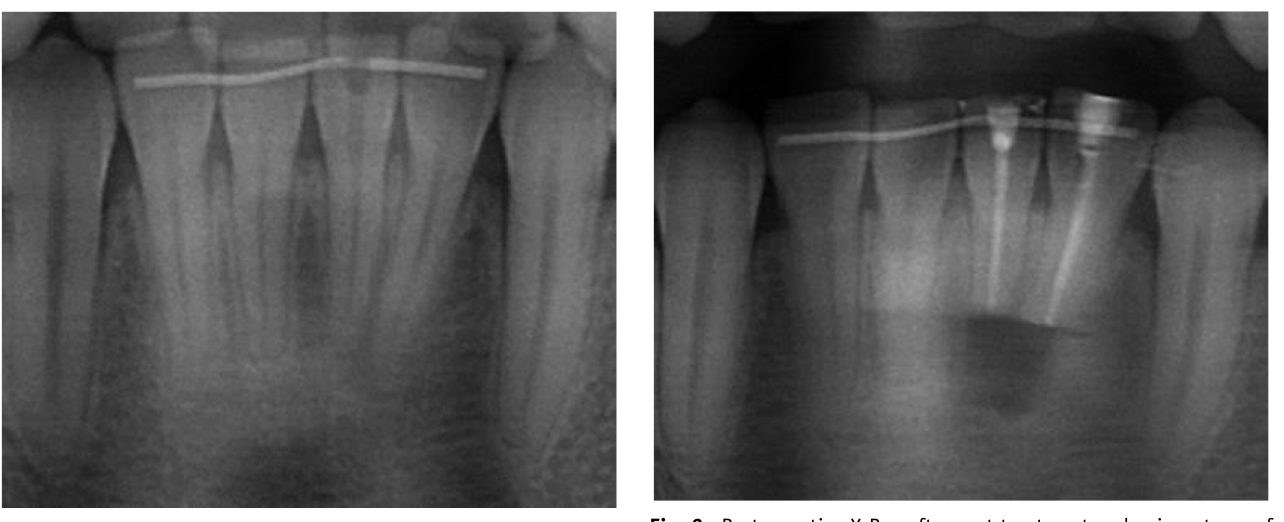
Fig. 1. Periapical X-ray showing preoperative lesion on the apices of teeth 31 and 32.